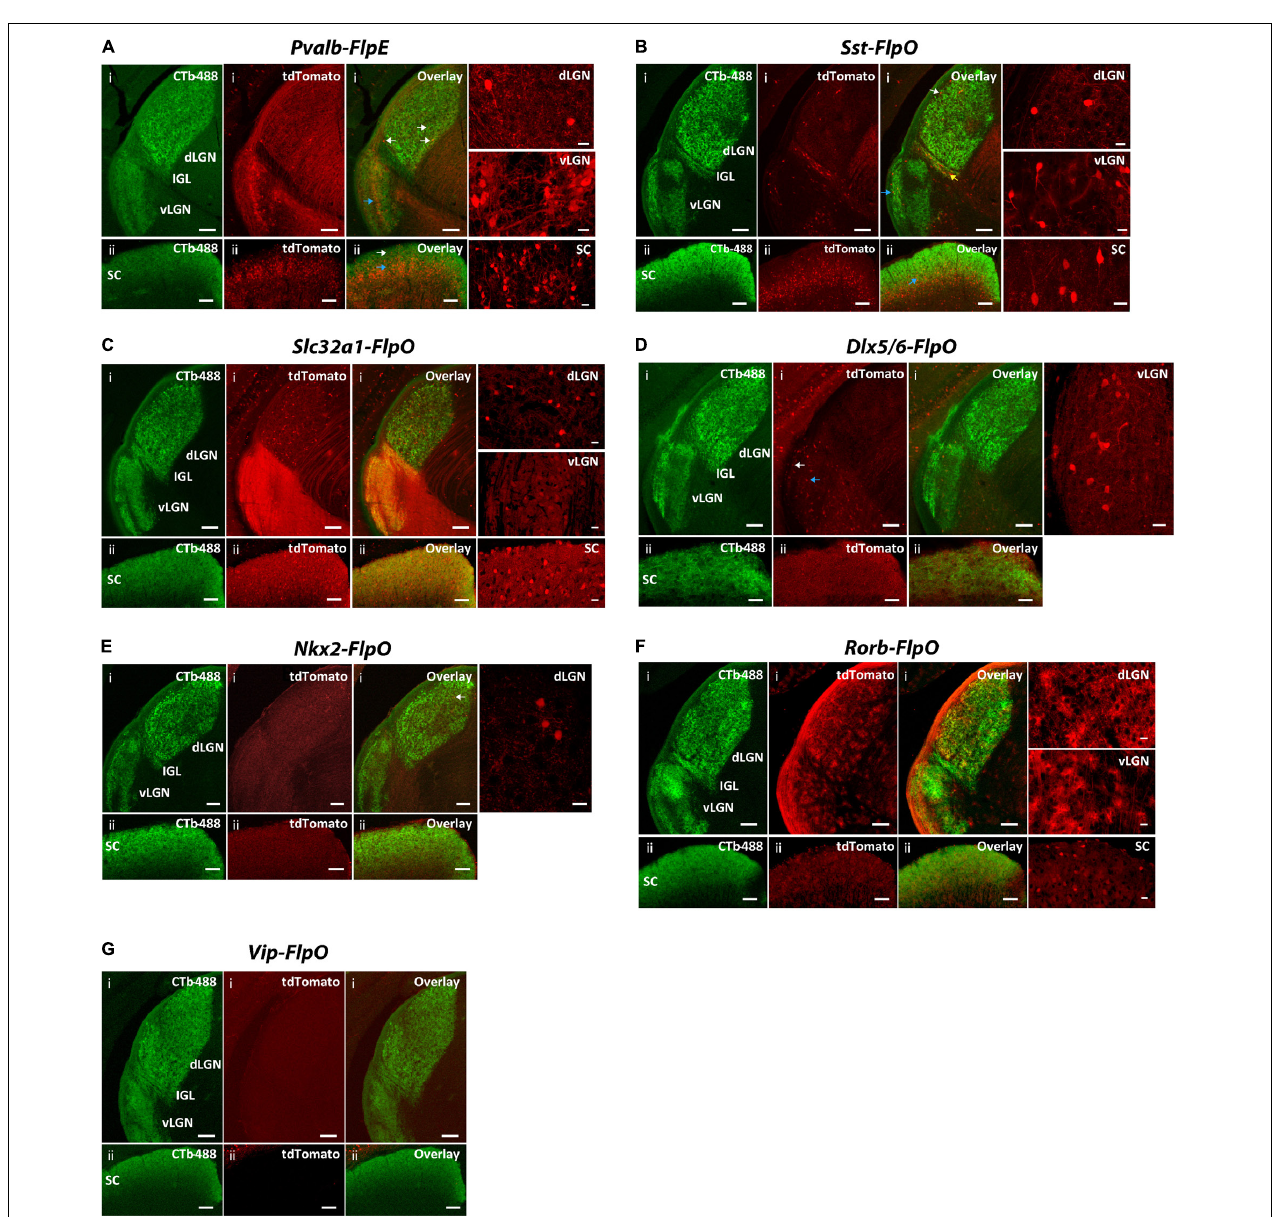
FIGURE 7 | Expression patterns of Flp drivers in the SC and the LGN. FLP-expressing cells were labeled with tdTomato (red) in CMV-Cre;Flp;Ai65 mice. Retino-recipient zones were labeled with cholera toxin B conjugated to Alexa Fluor 488 (CTb-488) (green) injected to the eyes. (A) Pvalb-FlpE driver. In the SC, FLPe strongly expressed in the deep layer ( ii , blue arrow) but sparsely expressed in the superficial layer ( ii , white arrow). The middle layer of vLGN also strongly expressed FLPe ( i , blue arrow). The dLGN showed very sparse labeling ( i , white arrows). Intense tdTomato background comes from axons of FLPe + RGCs. (B) Sst-FlpO driver. Strong FLPo expression was found in the deep layer of the SC ( ii , blue arrow). Only sparse labeling was found in the vLGN and dLGN, while most of the labeled cells were in the superficial layer ( i , white arrow for dLGN, blue arrow for vLGN). There was also moderate labeling in IGL (yellow arrow). (C) Slc32a1-FlpO targeted FLPo expression broadly to all the layers in the LGN and SC. (D) Dlx5/6-FlpO driver. FLPo expression was sparse and restricted primarily to the superficial ( i , white arrow) and middle layer of the vLGN ( i , blue arrow). No FLPo labeling was found in SC and dLGN. (E) Nkx2-FlpO driver. In the dLGN, sparely labeled cells were found in the core region ( i , arrow). There was no labeling in other areas. (F) Rorb-FlpO driver. FLPo expression was observed in neurons in all layers in the SC (ii) , as well as glial cells in the entire LGN including both the dLGN and the vLGN (i) . (G) Vip-FlpO driver did not express in either the LGN or the SC. For each driver, examples of enlarged labeling area are shown on the right. Scale bar: 100 µ m for the LGN, 50 µ m for the SC, 20 µ m for the enlarged regions.